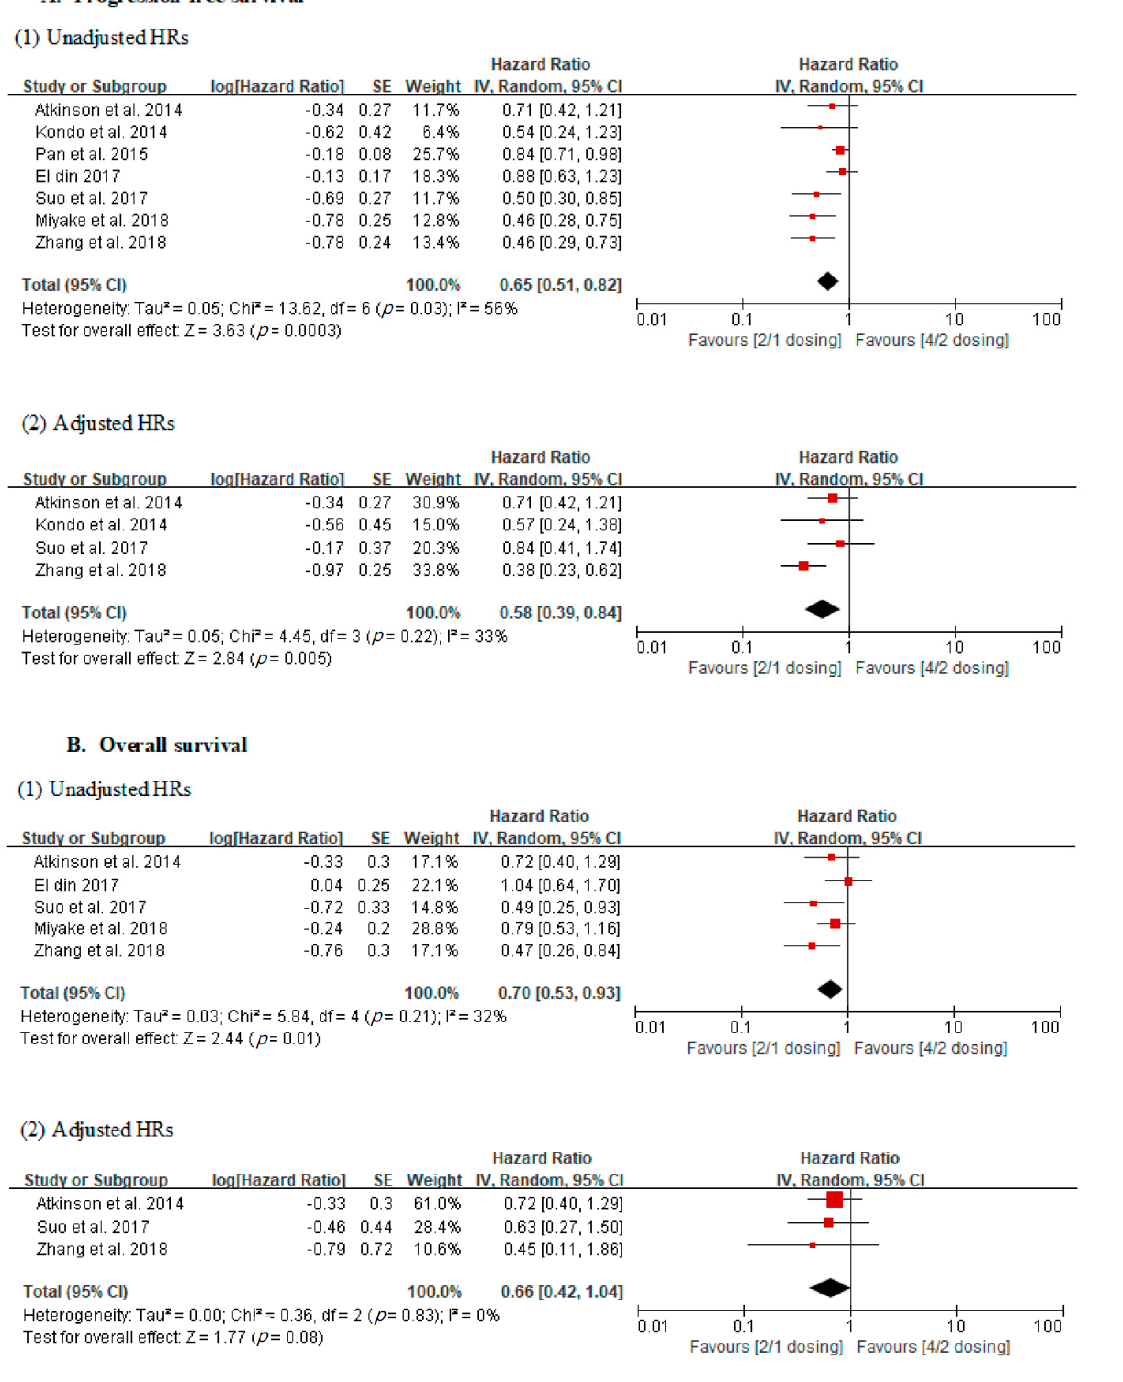
Figure 2. Forest plots of oncological outcomes according to dosing schedules.